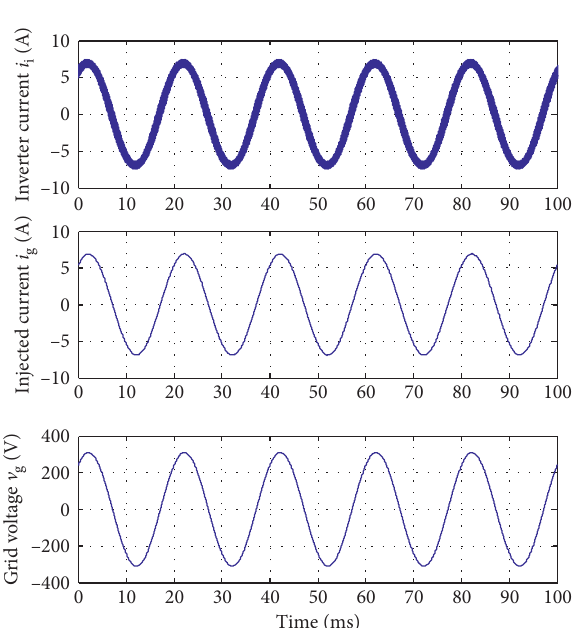
Figure 12: Simulation result when AD is poles stay inside the unit circle. Simulation results show the